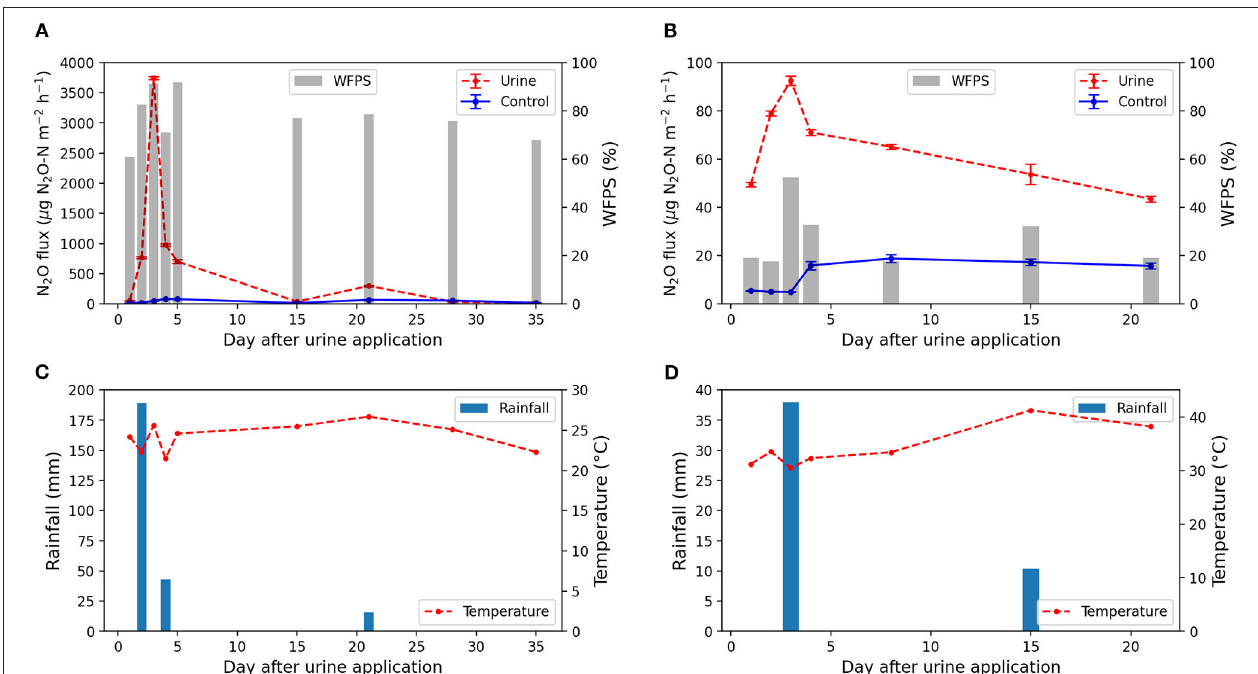
FIGURE 1 | Soil nitrous oxide emission following urine application and percent water-filled pore space saturation (WFPS) ( A -Casanare and B - Atlántico), and Rainfall and temperature ( C -Casanare and D -Atlántico). Solid arrows indicate time of urine application. Vertical bars in (A) and (B) show the standard error ( n = 4).